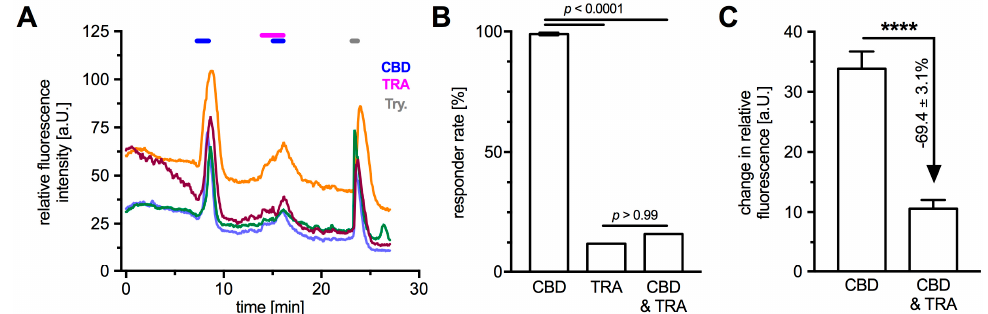
Figure 4. Application of the TRPV2-blocker TRA provided further evidence for functionality of TRPV2 in HTPCs during Ca 2+ imaging. ( A ) In presence of CB1 and CB2 blockers (AM251 and AM630), application of TRPV2 activator CBD (10 µM) led to a transient increase in intracellular Ca 2+ that could partially be blocked by TRA (10 µM). Graph shows original traces of four representative cells; three individual donors were analyzed. In all experiments, trypsine (1‰) served as positive control. ( B ) The total rate of responding cells upon CBD application was 99.0 ± 0.6% (25 cells from 3 donors). TRA application elicited transients in 12% of the analyzed cells and combination with CBD led to a responder rate of 16% (25 cells from 3 donors). The data were analyzed using Fisher’s exact test. ( C ) Application of TRA significantly reduced the measured changes in fluorescence intensity compared to the initial CBD-induced Ca 2+ transients (**** p < 0.0001; 25 cells from 3